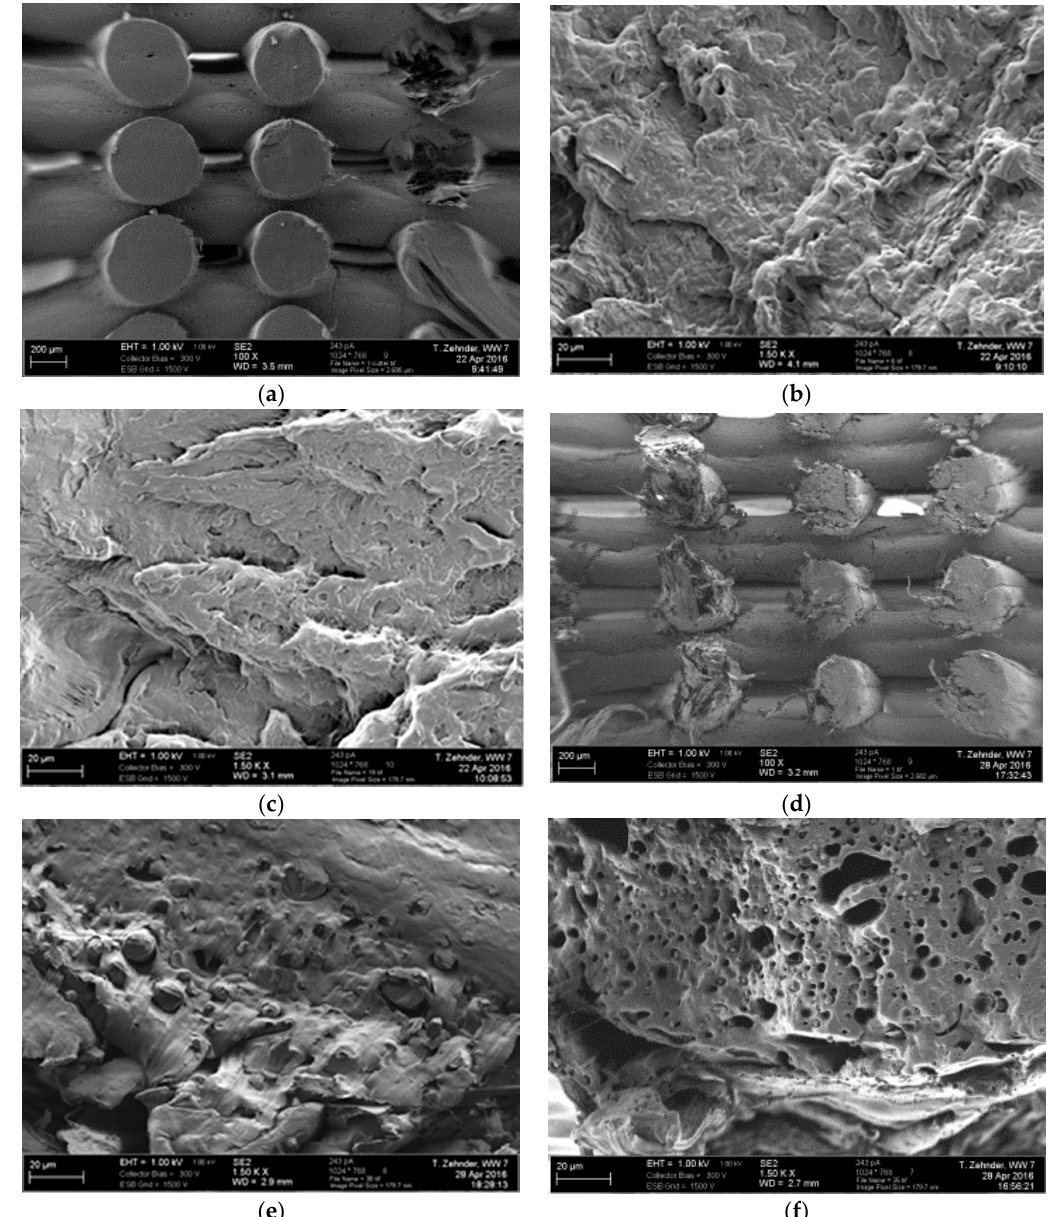
Figure 9. Electron microscopy images of the cross-sections of PCL scaffolds as fabricated ( a , b ), and after three days of incubation in HBSS ( c ); and PCL-PEG 7030 scaffolds as fabricated ( d , e ), and after three days of incubation in HBSS ( f ) at 37 °C.